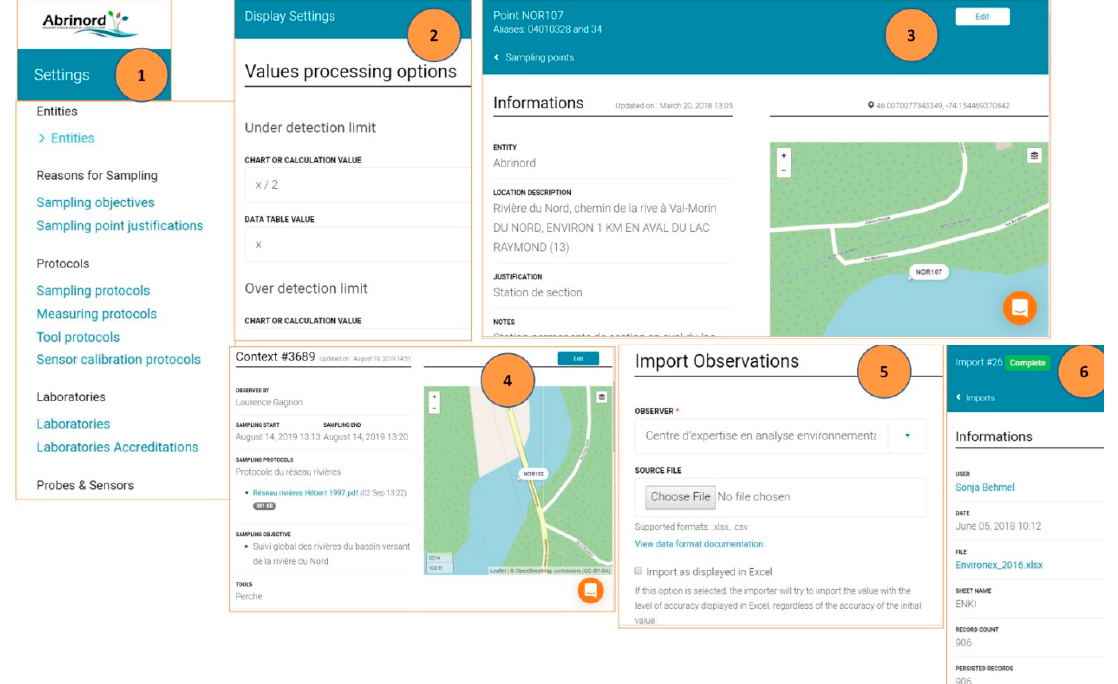
Figure 6. Onboarding the data of a WQMP: Step 1: Setting (e.g., sampling objectives; sampling site justification; protocols; tools; probes; probe calibration protocols; laboratories; laboratory specificities; field observations; parameters and measuring units. Step 2: Importing shapefiles of watersheds and water bodies, metadata on shapefiles; waterbody descriptions (e.g., bathymetry, length, fetch, volume, perimeter, etc.). Step 3: Creating sampling sites (e.g., geographical location, justification, waterbody (from drop-down lists created during steps 1 and 2. Step 4: Entering measurement contexts – fieldwork (e.g., field personnel, time frame spent in the field, sampling protocols, sampling tools; probes and laboratories used, field measurements are taken (e.g., transparency), field observations (e.g., rainfall and wind), etc.). Step 5: Importing data from Excel and CSV files from probes and laboratories automatically